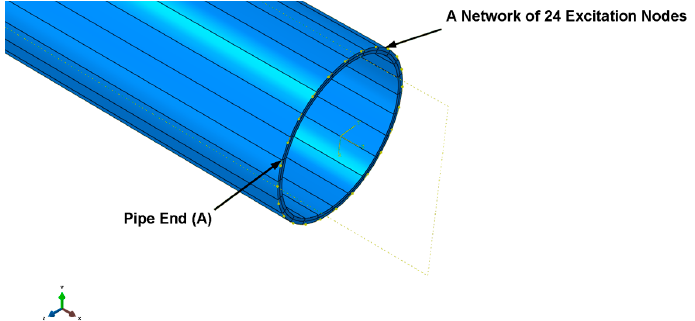
Figure 6. Determined excitation nodes in the simulations at the pipe end (A) for exciting guided torsional wave, T(0,1) mode, in the circumferential direction.